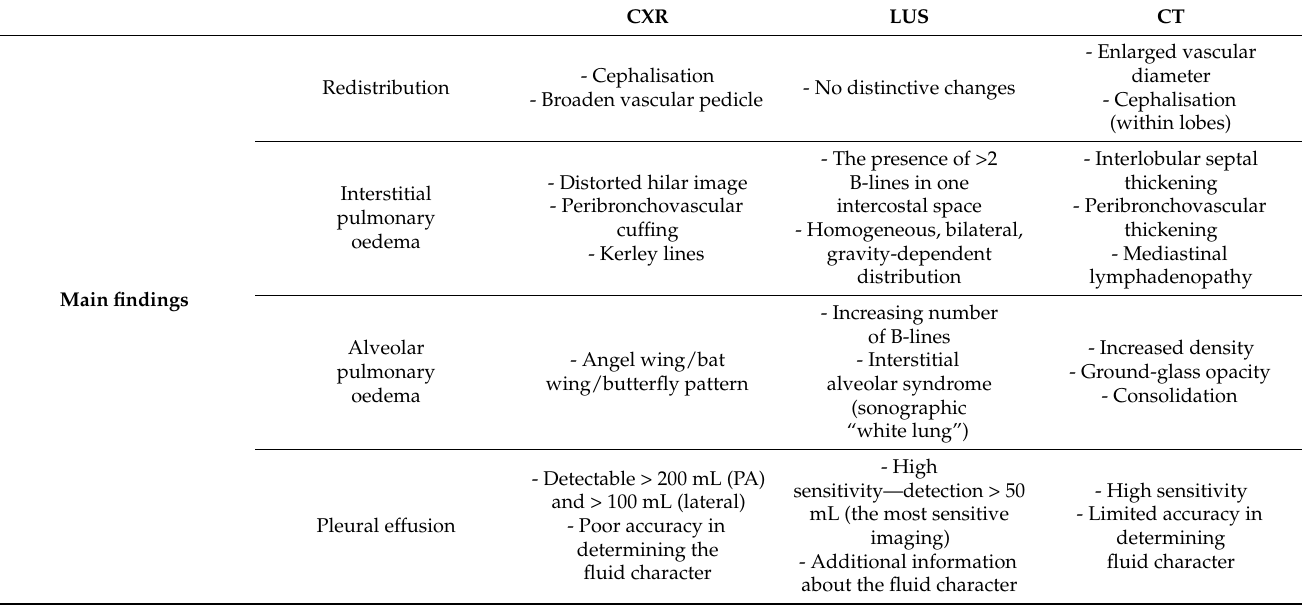
Table 2. Main findings in different stages of the pulmonary image in HF. A comparison of the advantages and disadvantages of various radiographic modalities is